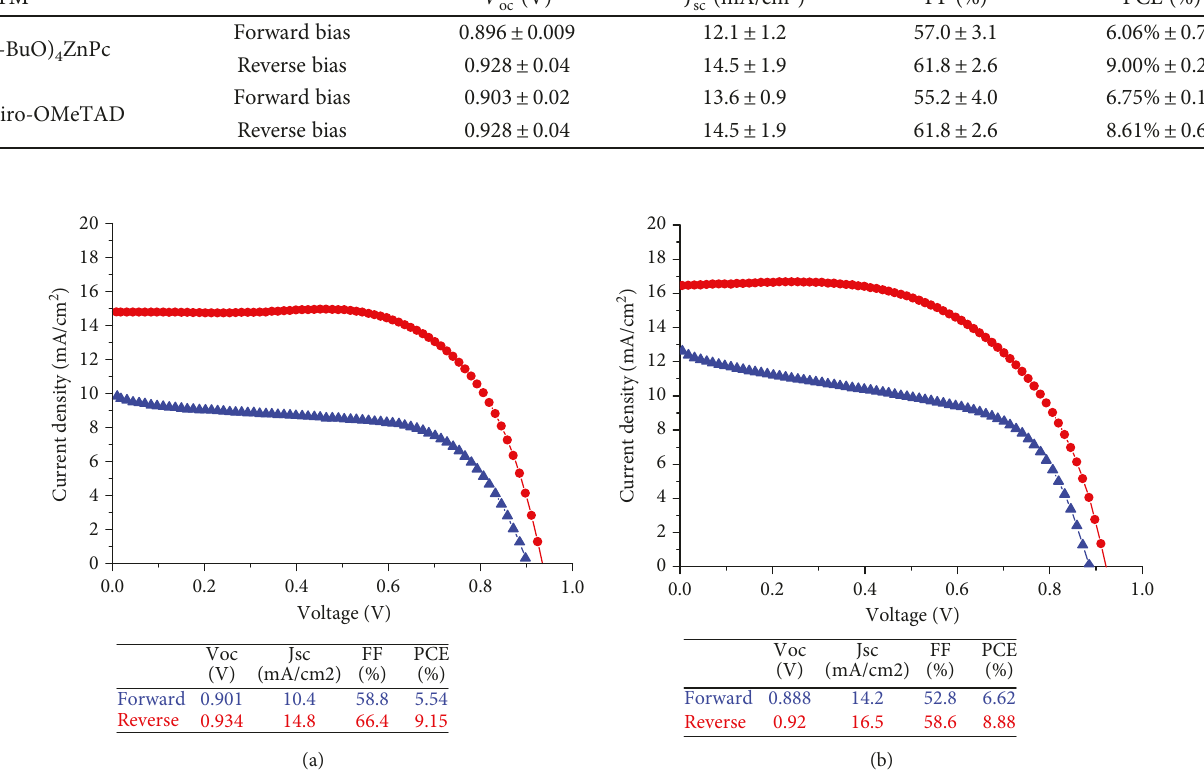
ZnPc and (b) Spiro-OMeTAD-based 4